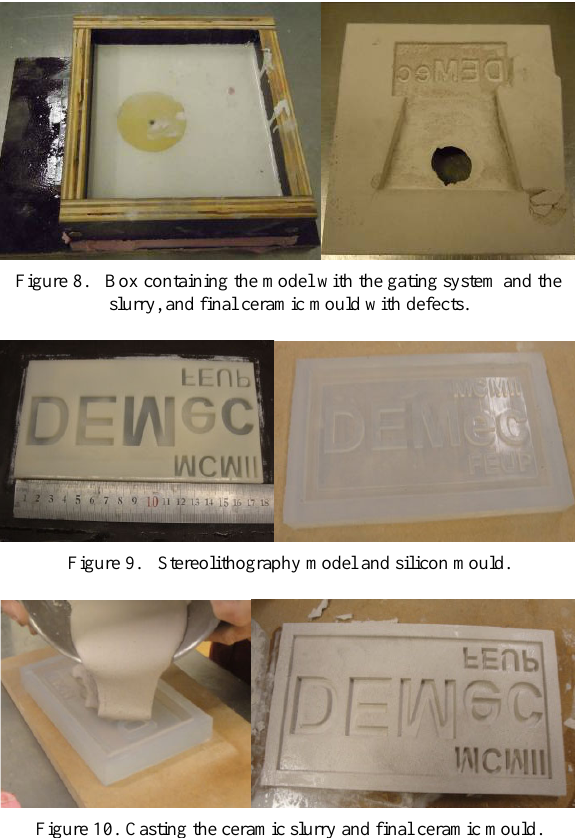
Figure 12. Manufacturing sequence to produce a metallic part using the investment casting